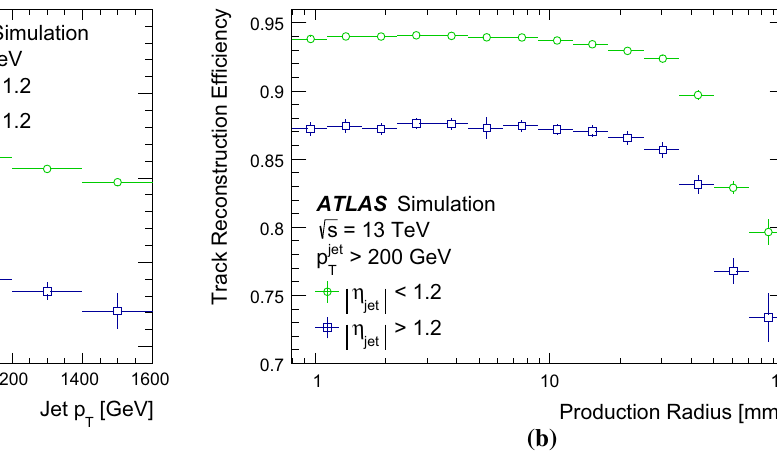
charged particle for simulated dijet MC events, where charged particles are not required to be created before the